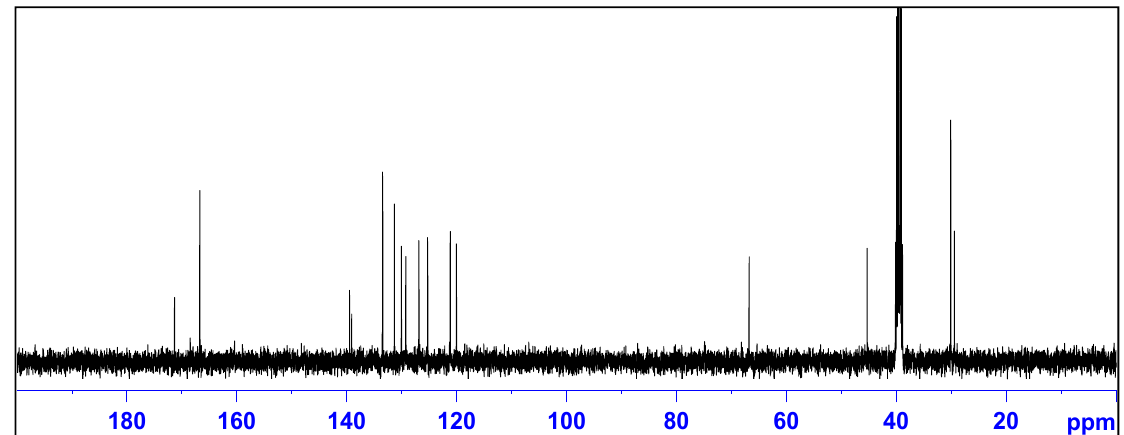
Figure 2. 13 C-NMR spectrum of 2,2,4-trimethyl-2,3-dihydro-1 H -1,5-benzodiazepin-5-ium isophthalate I